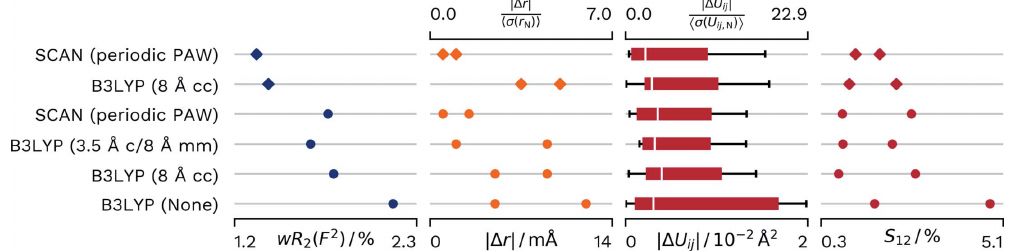
Figure 8 Differences in wR 2 ( F 2 ) and agreement with neutron values for different density sources for HAR of Urea . The two independent values for X —H distances and H-atom S 12 are displayed as points. Distributions of atomic displacement parameters are displayed as box-whisker plots. SCAN (Periodic PAW) was conducted with our script and GPAW . The B3LYP (3.5 A˚ c, 8 A˚ mm) values are from the reference calculation from the literature (Chodkiewicz et al. , 2020) and used a 3.5 A˚ cluster that was fully calculated and 8 A˚ of point multipoles for the crystal approximation. B3LYP (8 A˚ cc) uses 8 A˚ of cluster charges and was refined with NoSpherA2 / TONTO . B3LYP (None) was calculated with NoSpherA2 / ORCA without any approximation of the crystal environment. The refinements marked with diamonds were minimized with additional Gram–Charlier